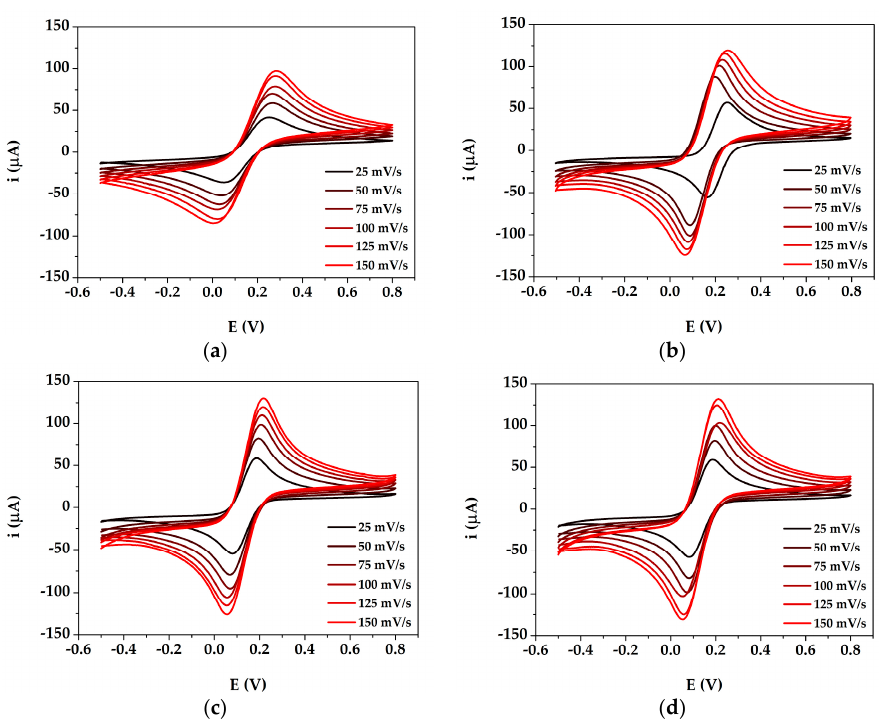
Figure 2. Cyclic voltammograms of bare and modified GSPEs in 5 mM [Fe(CN) 6 ] 4 − /3 − with 0.1 M KCl. ( a ) GSPE; ( b ) PANI/GSPE; ( c ) AuNPs/GSPE; ( d ) AuNPs@PANI/GSPE. Experimental parameters: potential range from − 500 mV to +800 mV; scan rates 25, 50, 75, 100, 125 and 150 mV/s.